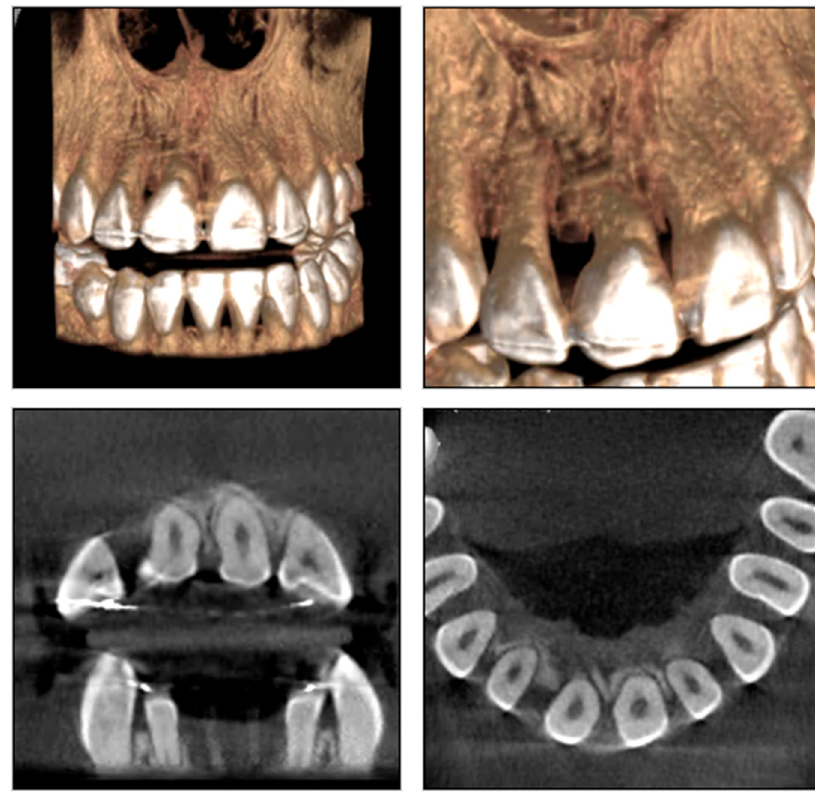
Figure 11. Post-op cone-beam computed tomography